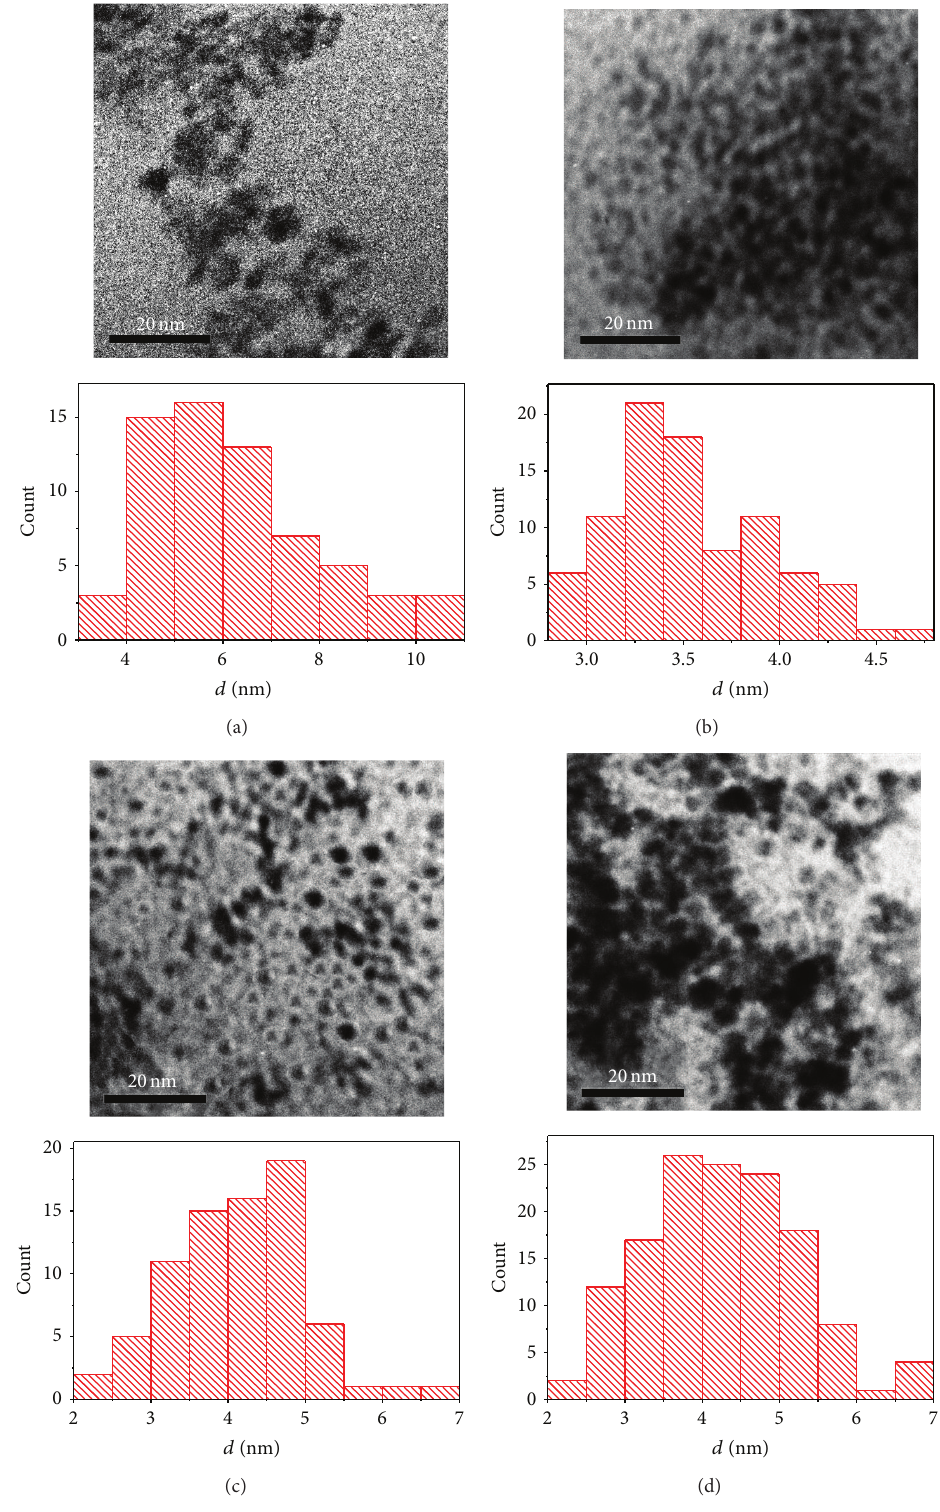
Figure 3: TEM images of the NPs obtained from a diethylene glycol solution: ( 1 ) MnFe 2 O 4 ; (b) CoFe 2 O 4 ; (c) NiFe 2 O 4 ; (d) ZnFe 2 O 4